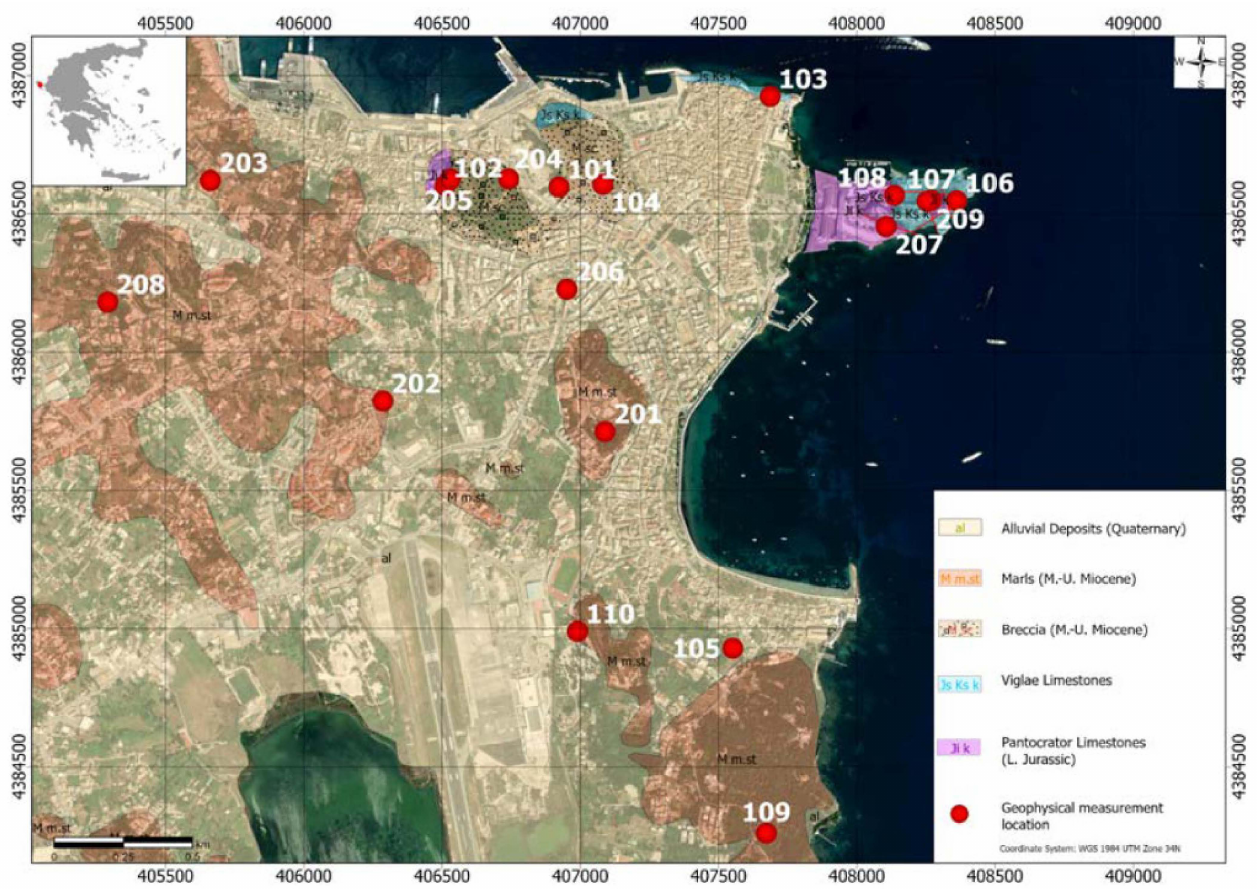
Figure 1. Modified geological map of Corfu town